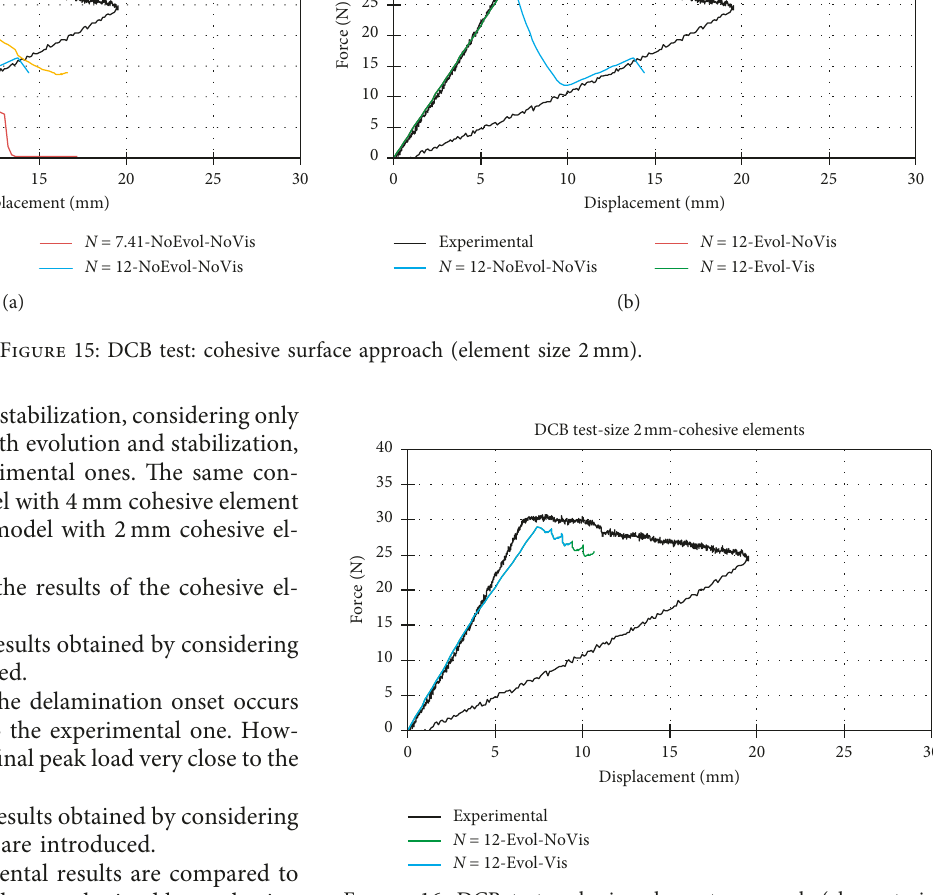
Figure 16: DCB test: cohesive element approach (element size 2 mm).